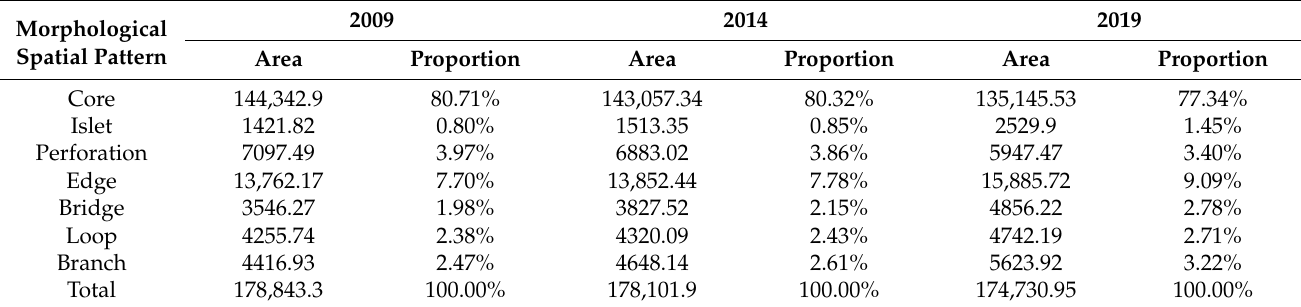
Table 9. The area and proportion of MSPA classes in woodlands of Anyuan County (Unit: